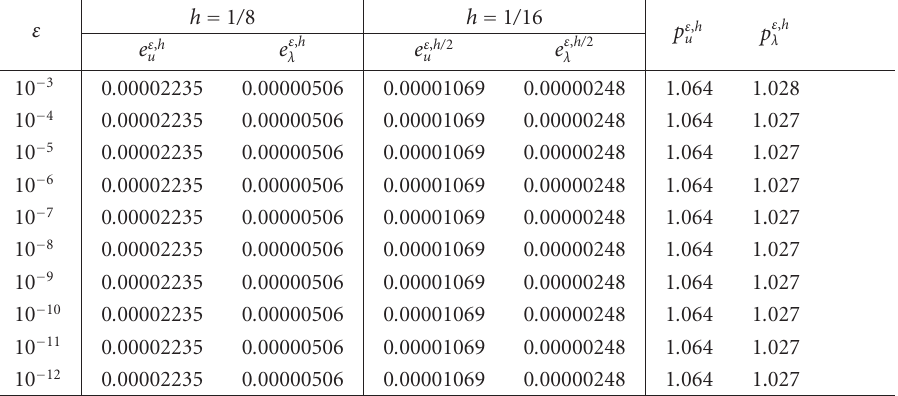
} and convergence rates { p ε , h , e ε , h u λ